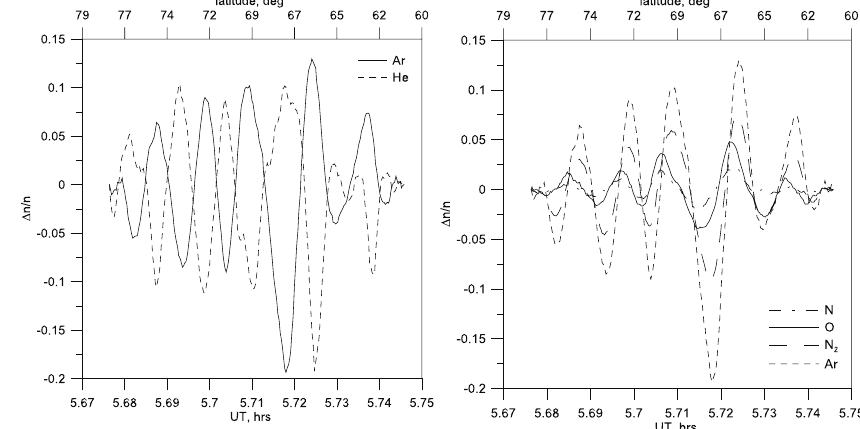
Figure 2. Relative density variation of Ar and He (left) and N, O, N 2 , and Ar (right) above the